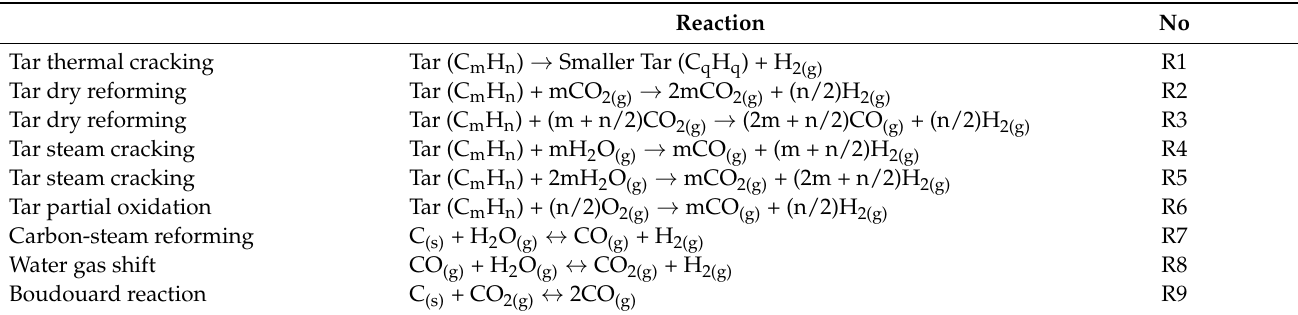
Table 3. The main reaction network during biomass CO 2 gasification.